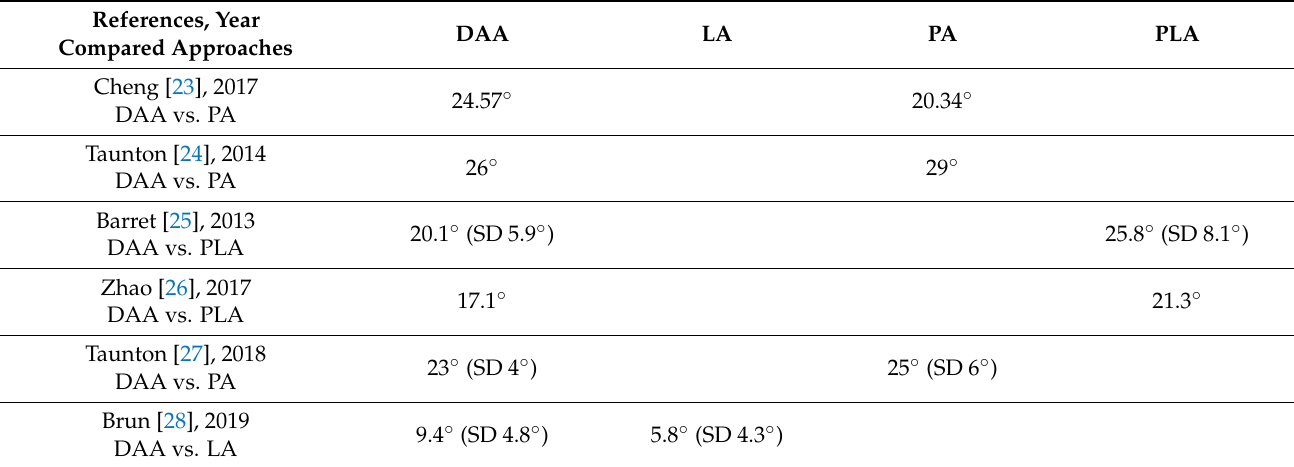
Table 6. Mean radiographic cup anteversions in analyzed